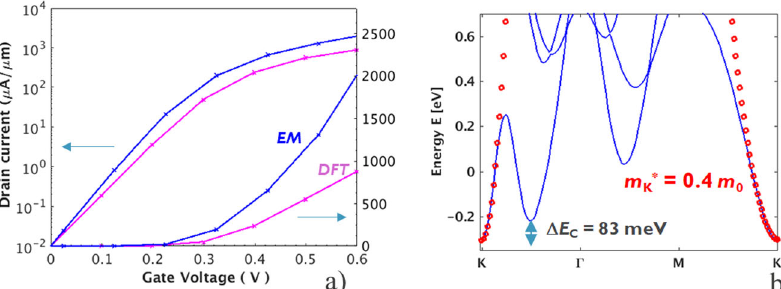
Fig. 3 DFT vs fi tted effective-mass (EM) model. a Drain-current – gate-voltage, I D ( V G ), characteristics of a L = 5 nm 1ML-WS 2 -DG nMOSFET computed with DFT and a fi tted EM model (including the two fi rst valleys seen in Fig. 3b). V D = 0.6 V. b DFT-computed band structure around E C (blue line) and that fi tted with the 1st valley (centered at K -point) isotropic effective mass = 0.4 m 0 (red stars), m 0 being the free electron mass. Despite that a good agreement between the EM- and the DFT-band structure model is achieved in the vicinity of E C , the EM-NEGF model strongly overestimates the current drive in the device . The second valley (located between K and Γ ) was also fi tted with an EM of 0.9 m 0 and included in the effective-mass NEGF